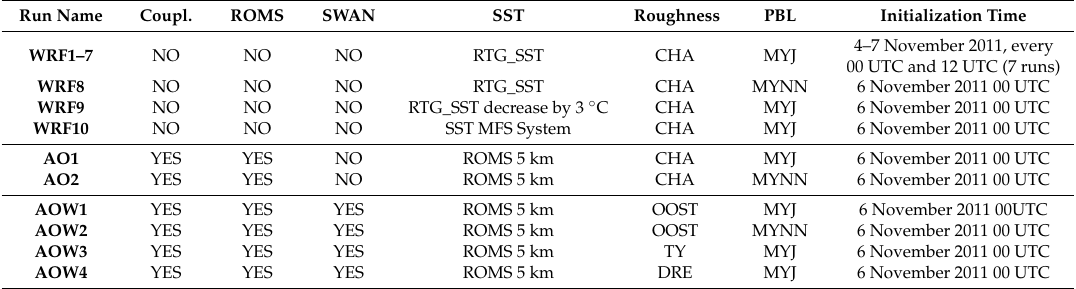
Table 1. Summary of all performed runs and their numerical setup. Acronyms used: CHA = Charnock [46]; OOST = Oost et al. [52]; TY: Taylor and Yelland et al. [49]; DRE: Drennan et al. [51]. MYI: Mellor-Yamada-Janjic’ [44]; MYNN: Mellor Yamada, as in